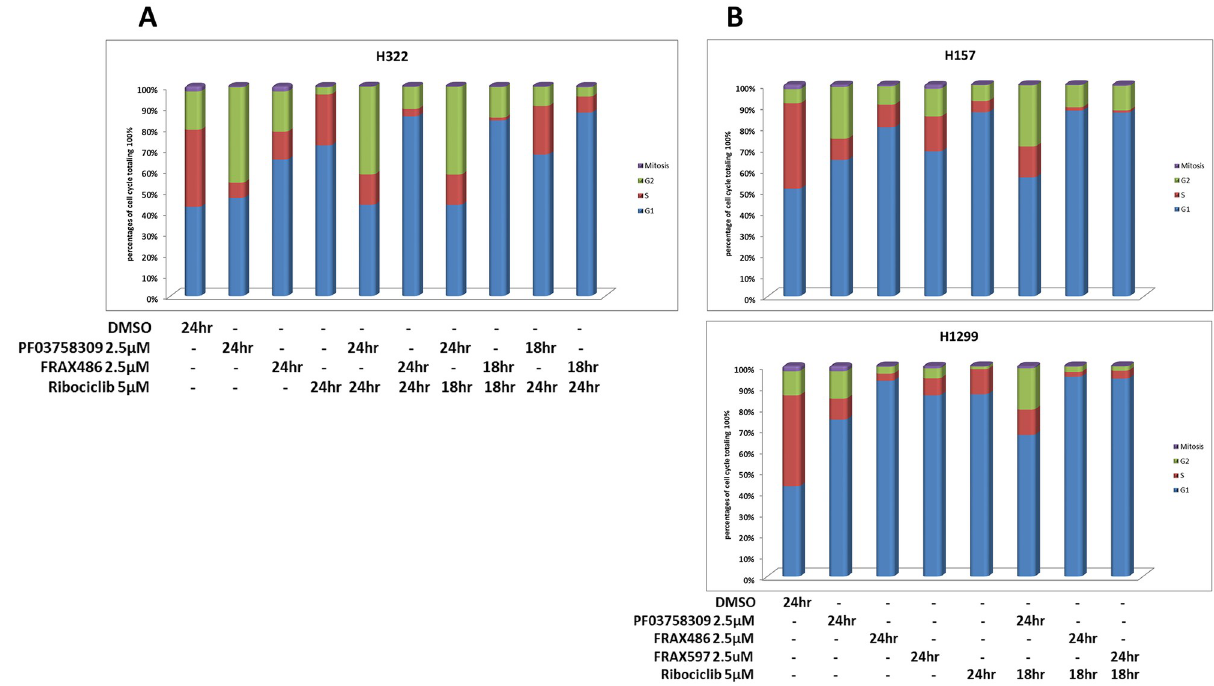
Fig 2. Cell cycle arrest and apoptosis. A . Percentage of H322 cells in various stages of the cell cycle after 24 hours for single drug (PF03758309, FRAX486 and Ribociclib) or drug combination, as well as with consecutive drug addition at 24 hours and 18 hours before harvest. B . Percentage of H157 or H1299 cells in various stages of the cell cycle after 24 hours for single drug or combination drug with PAKi (including FRAX597), added for 24 hours, and Ribociclib for 18